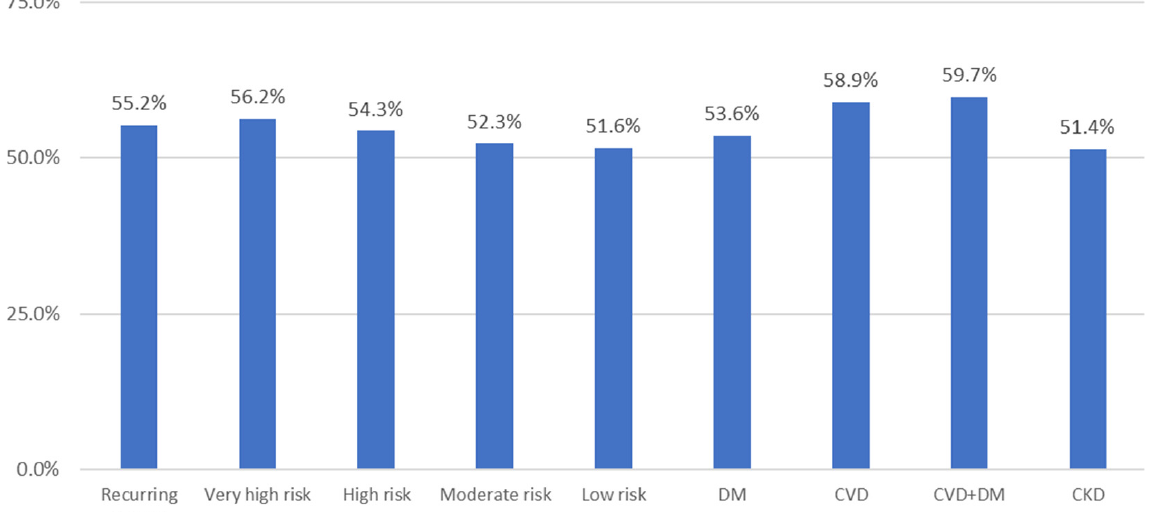
Figure 4. Rate of dyslipidemia control estimated by the physicians in different situations. DM: diabetes mellitus; CVD: cardiovascular disease; CKD: chronic kidney disease.